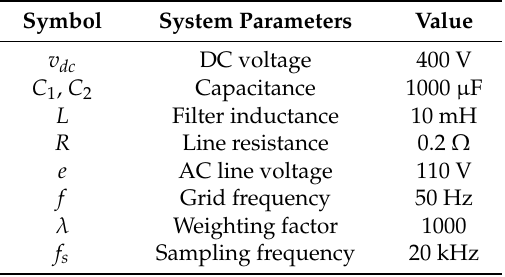
Table 2. Simulation and experiment